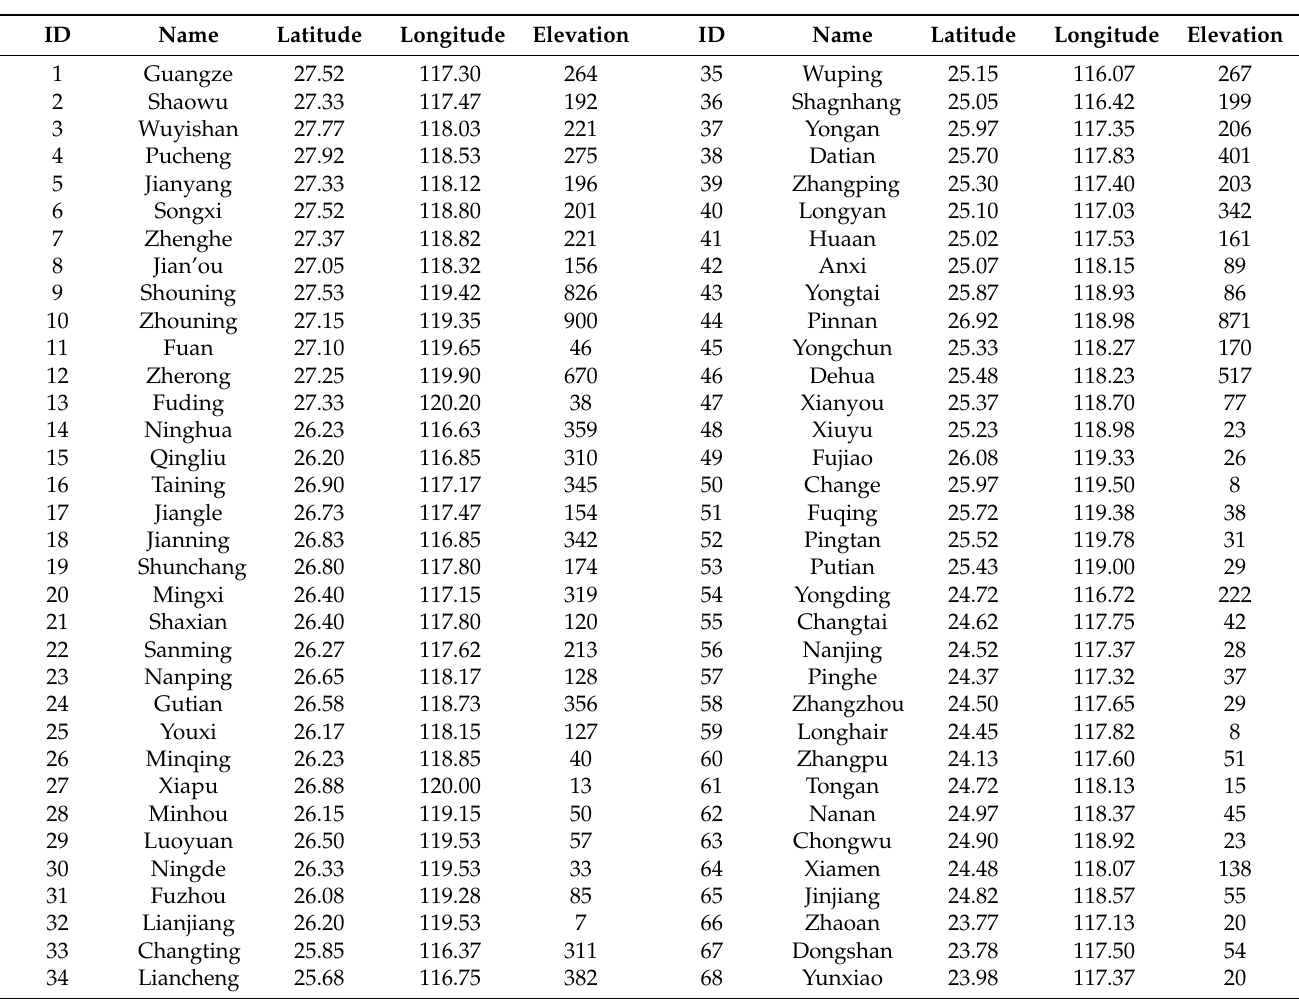
Table 1. Information of the meteorological